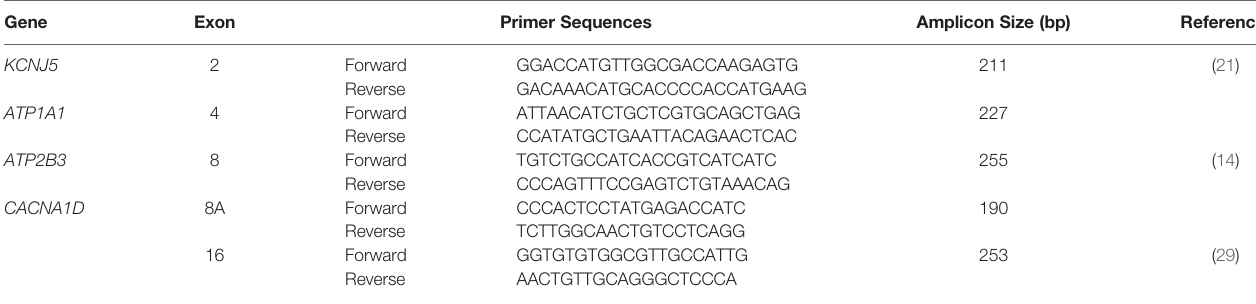
TABLE 2 | PCR primer sets for aldosterone-driver mutation